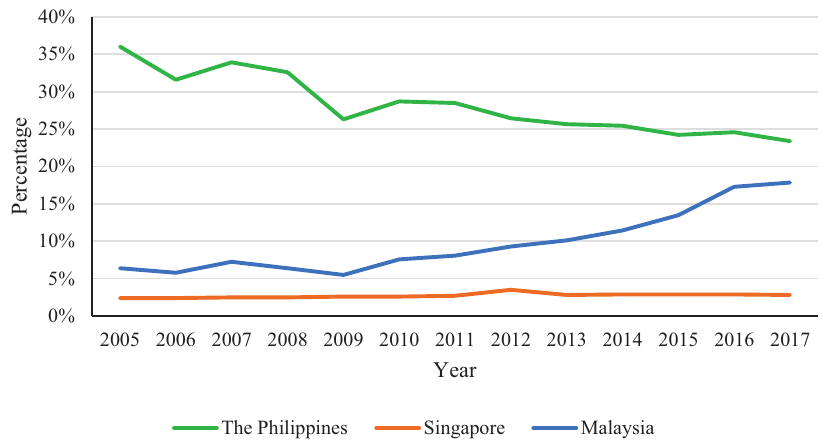
Figure 7. Percentage of renewable energy (RE) the generation mix in the Philippines, Singapore and